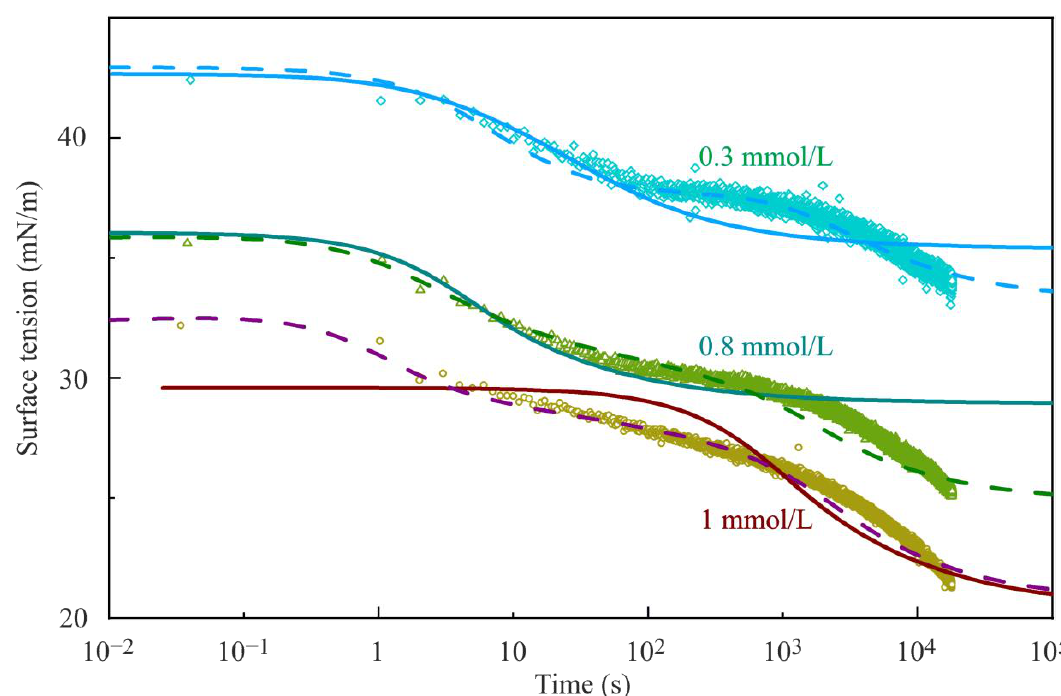
Figure 10. Dynamic interfacial tension of mixed aqueous solutions of NaC 6 SO 4 + C 12 TAB at the water/hexane interface measured by PAT-1; ( (cid:7) ) 0.3 mmol/L, ( ) 0.8 mmol/L, ( • ) 1 mmol/L; solid and dashed lines are calculated from the Frumkin and reorientation adsorption models, respectively.